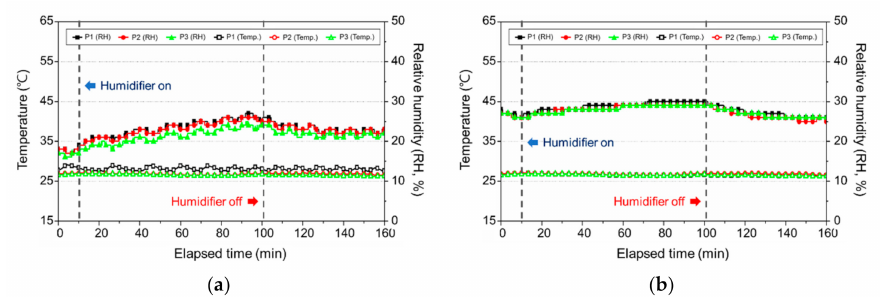
Figure 12. Temperature and relative humidity according to the use of a natural evaporative humidifier for each water type: ( a ) tap water (Seoul); ( b ) distilled